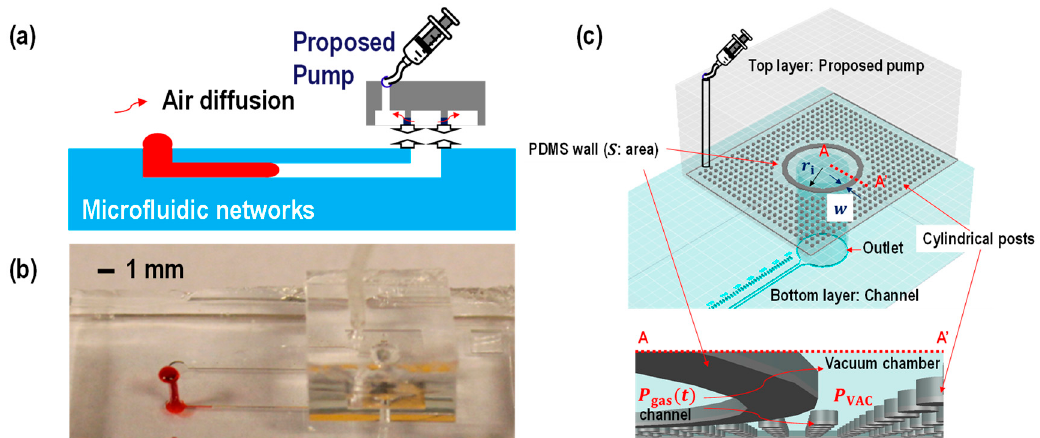
Figure 1. ( a ) A proposed device schematic ( b ) testing image and ( c ) three-dimensional view of the device. The bottom layer was designed to be a straight channel which is 14 mm long, 100 µm wide and 50 µm high. The top layer is designed to be a proposed pump. The inner radius of the polydimethylsiloxane (PDMS) wall (r i ) is set to be 1 mm while the PDMS wall thickness ( w ) is varied (i.e., 100 µm, 150 µm, and 200 µm) to study controlling flow rates. The height and PDMS membrane or PDMS wall shapes are also variant to study controlling flow rates. The cylindrical posts around the PDMS wall were made to avoid collapse while plungers were pulled to achieve manual vacuum condition in the vacuum chamber. Due to the gas permeability of the PDMS, the pressure difference across the PDMS membrane allows air diffusion from inside the membrane (the fluidic channel) to the outside of the PDMS membrane (the vacuum chamber).